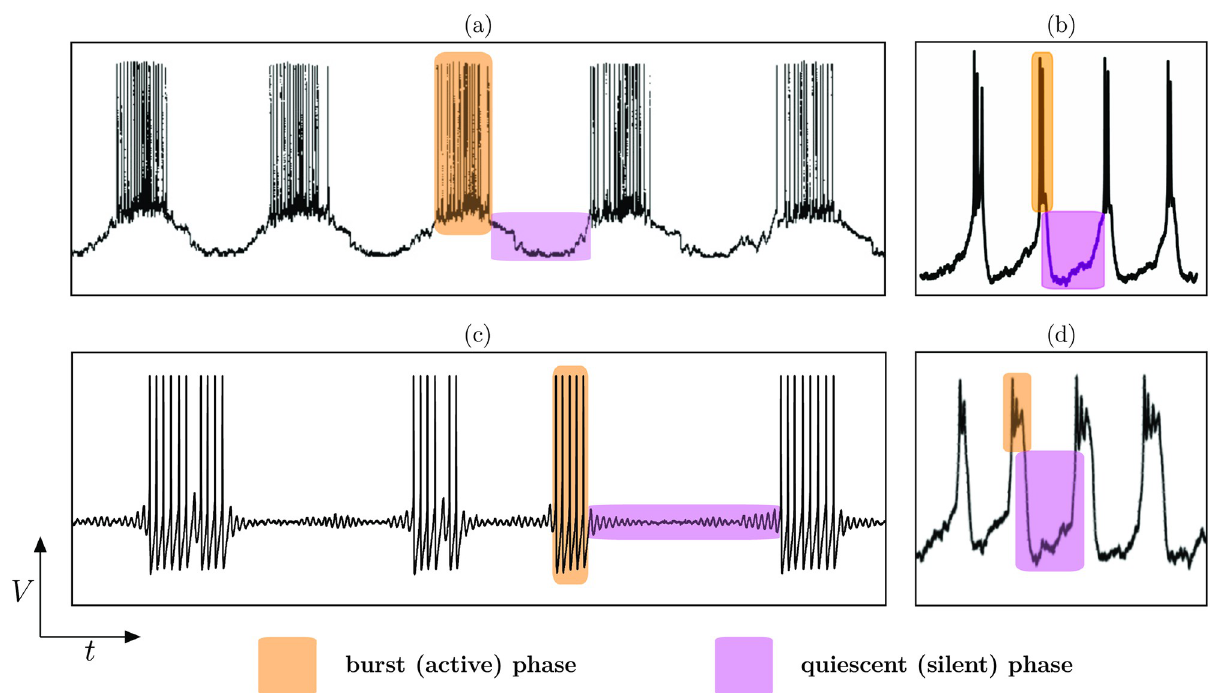
Fig 2. Example of electrophysiological recordings of bursting oscillations in 4 types of neurons: (a) parabolic-type bursting from the CeN neuron from the melibe (a sea slug) [26]; (b) square-wave-type bursting from a human β -cell [27]; (c) elliptic-type bursting from a dorsal-root-ganglia (DRG) neuron of a rat [28]; (d) pseudo-plateau-type bursting from a pituitary cell of a rat [29] (“Copyright 2011 Society for Neuroscience”). In each case, we highlight with colors the 2 main phases of bursting oscillations: silent (quiescent) and active (burst). Figures adapted with permission.